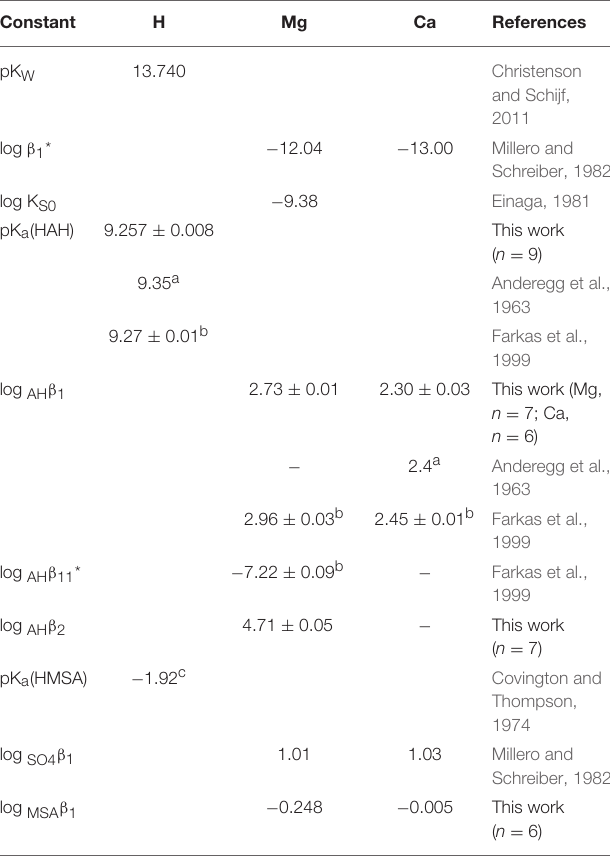
TABLE 4 | Twelve titrations (pH 3–10) of calcium in 0.7 M NaClO 4 solutions containing 5 or 10 mM acetohydroxamic acid (HAH), some in the presence of 140 mM mesylate (MSA − ).